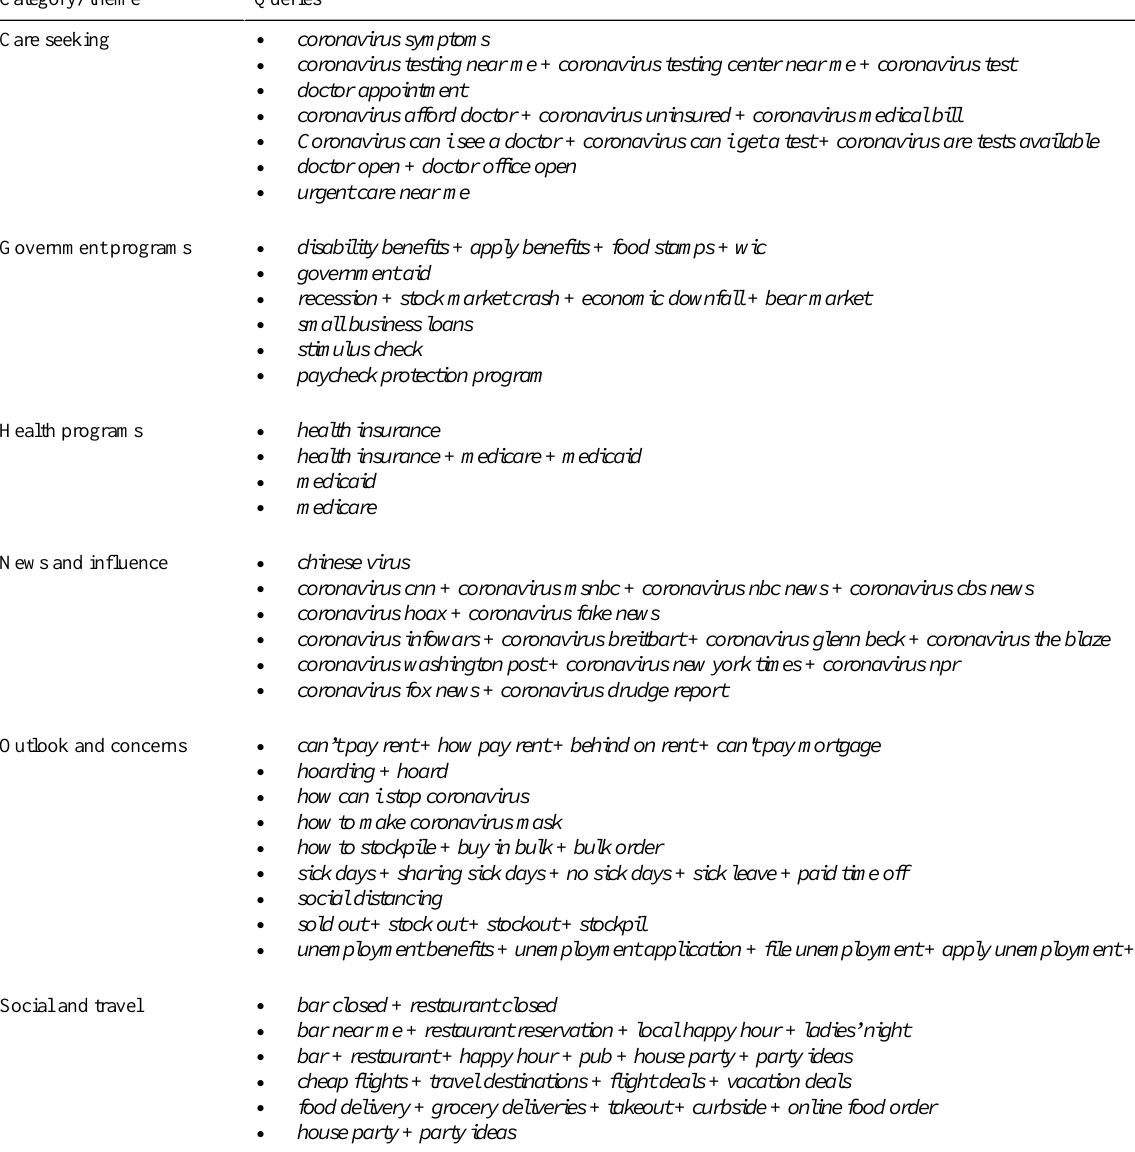
Table 1. Final list of search queries grouped into emergent themes (38 queries with 1-5 combined terms). QueriesCategory/